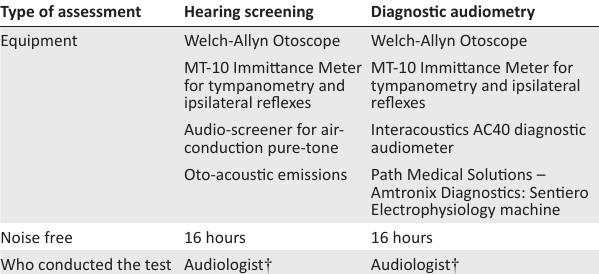
TABLE 2: Equipment used and procedures followed in the current study.